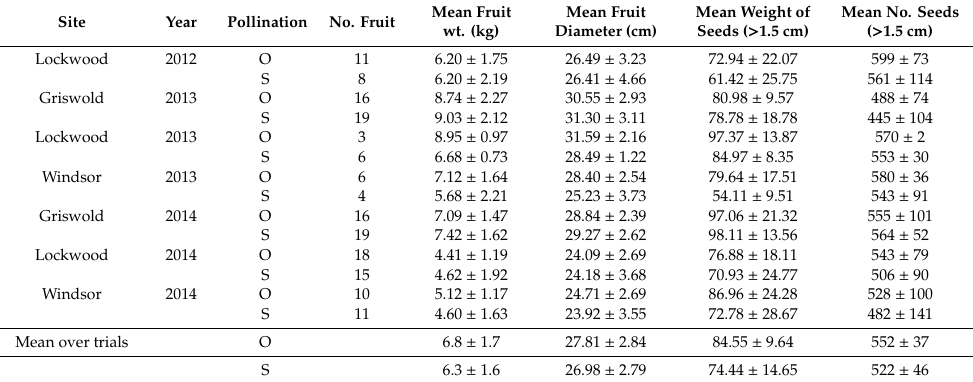
Table 2. Comparison of e ff ects (mean ± standard deviation) of open (O) or supplemental (S) pollination of pumpkin on fruit weight and diameter, seed weight, and number of seeds > 1.5 cm in